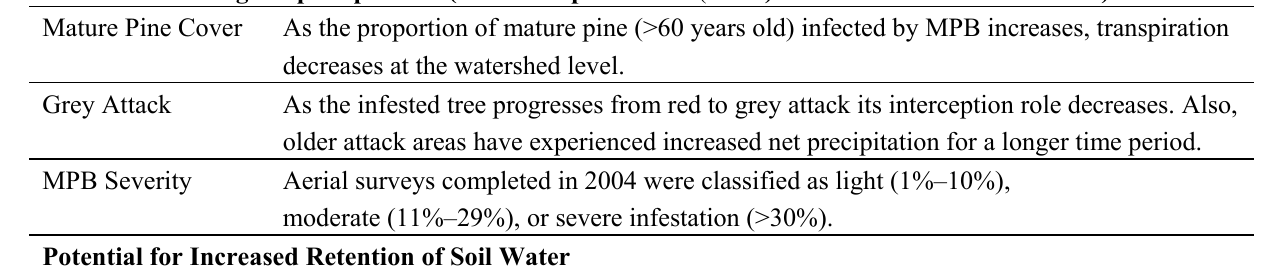
Table 1. Hazard indicators used to assess likelihood of wet ground areas in the Vanderhoof Forest District through the a priori